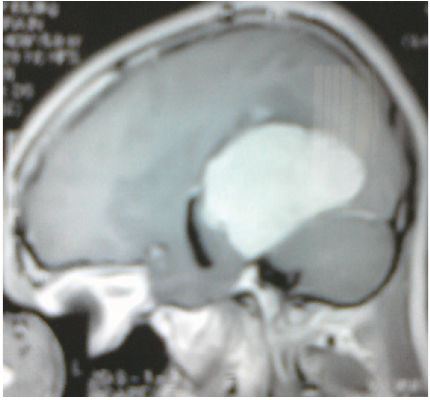
Figure 6: T2 image sagittal view.